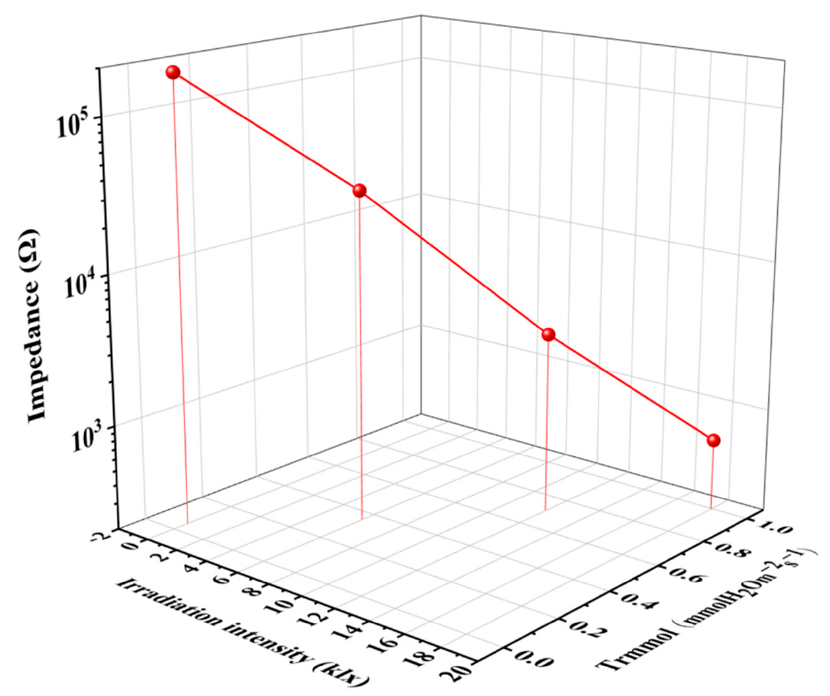
Figure 10. Impedance and transpiration rate (Trmmol) response of GO-based sensor un- irradiation der different irradiation intensities.